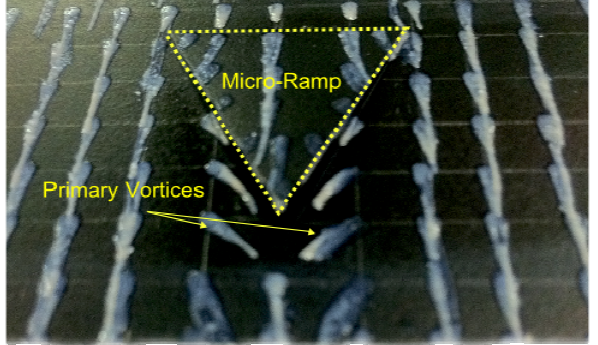
Figure 10. Oil-dot visualization results for Mach 5 flow by Saad et al .